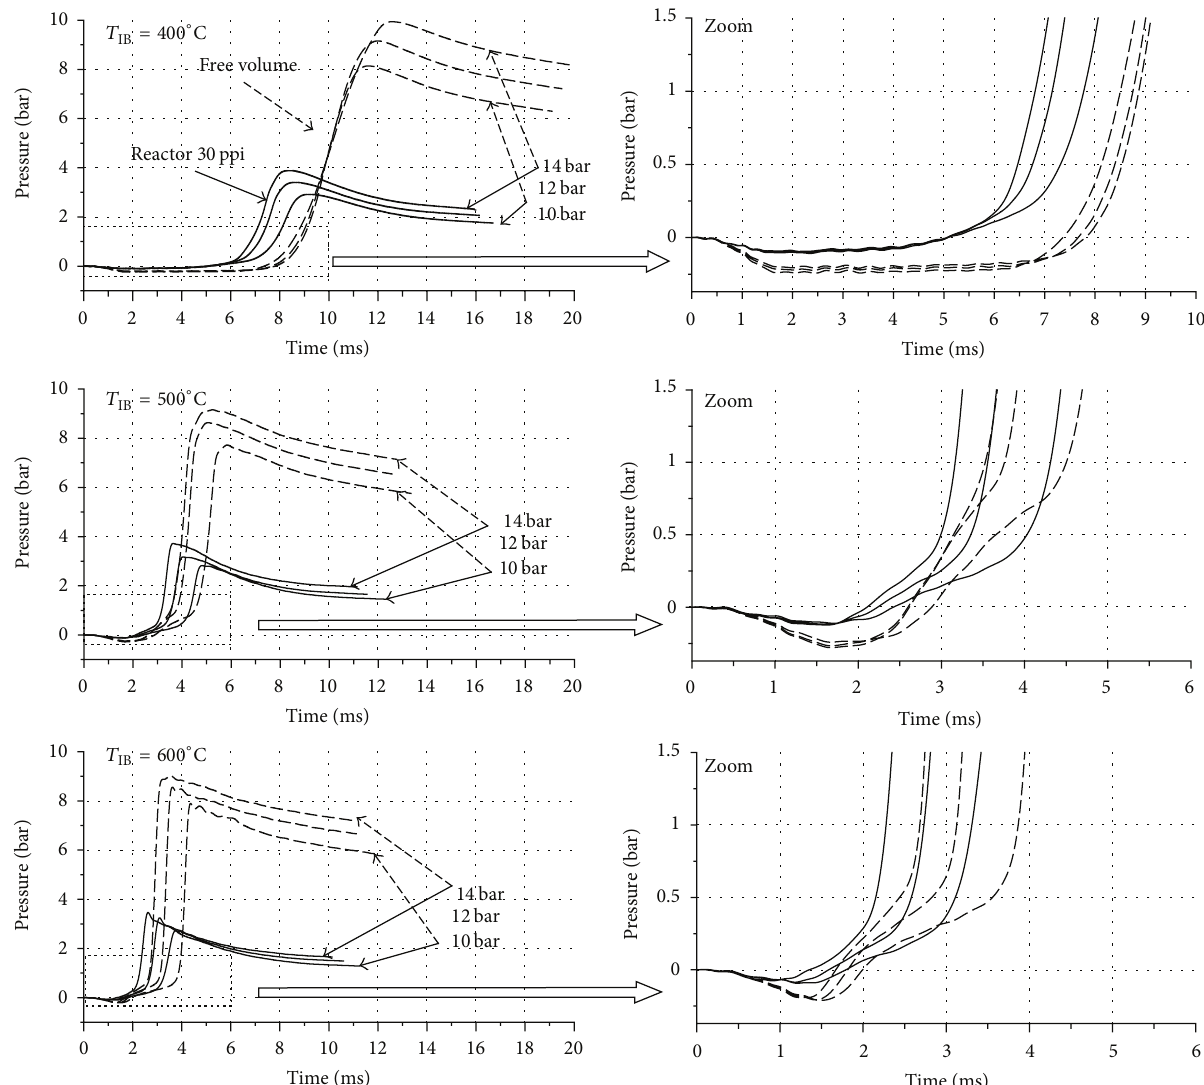
Figure 9: Comparison of pressure histories for heat release in free volume and in an SiC foam porous reactor (30ppi) after fuel injection starts at three different initial temperatures 400 ∘ C, 500 ∘ C, and 600 ∘ C, and for three initial pressures 𝑝 of injected fuel is 23.7 mg: left—complete pressure history; right—initial period of the process limited to 1.5 bar.